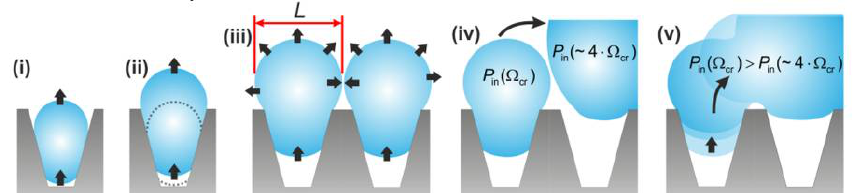
Figure 29. The dynamic behavior of droplets on ( a ) plain hydrophobic. ( b ) straight superhydropho- bic nanowire arrays. ( c ) 3D superhydrophobic nanowire networks surfaces. ( d ) The condensation heat transfer coefficient is a function of surface subcooling. Reprinted with permission from Ref [127]. Copyright 2018 Elsevier.